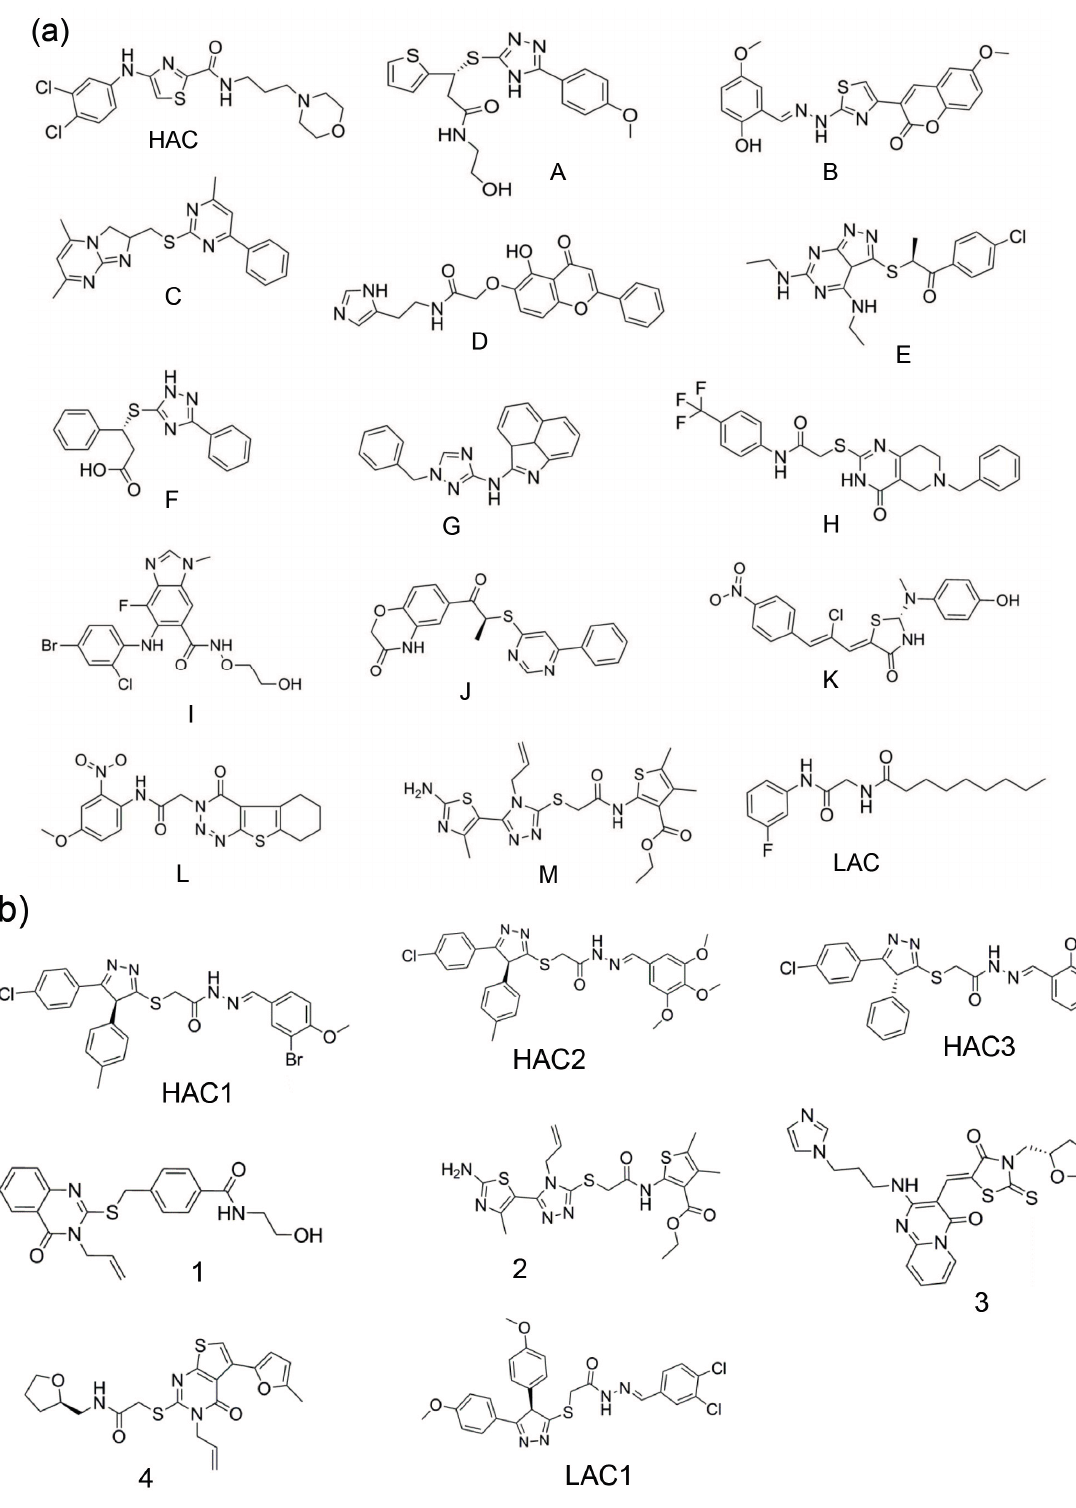
Figure 2. Molecules selected from the Otava PrimScreen1 library. ( a ) Selected molecules for the T-loop binding pocket; ( b ) Selected molecules for the RNA binding site. The LACS were not selected but are shown for illustrative